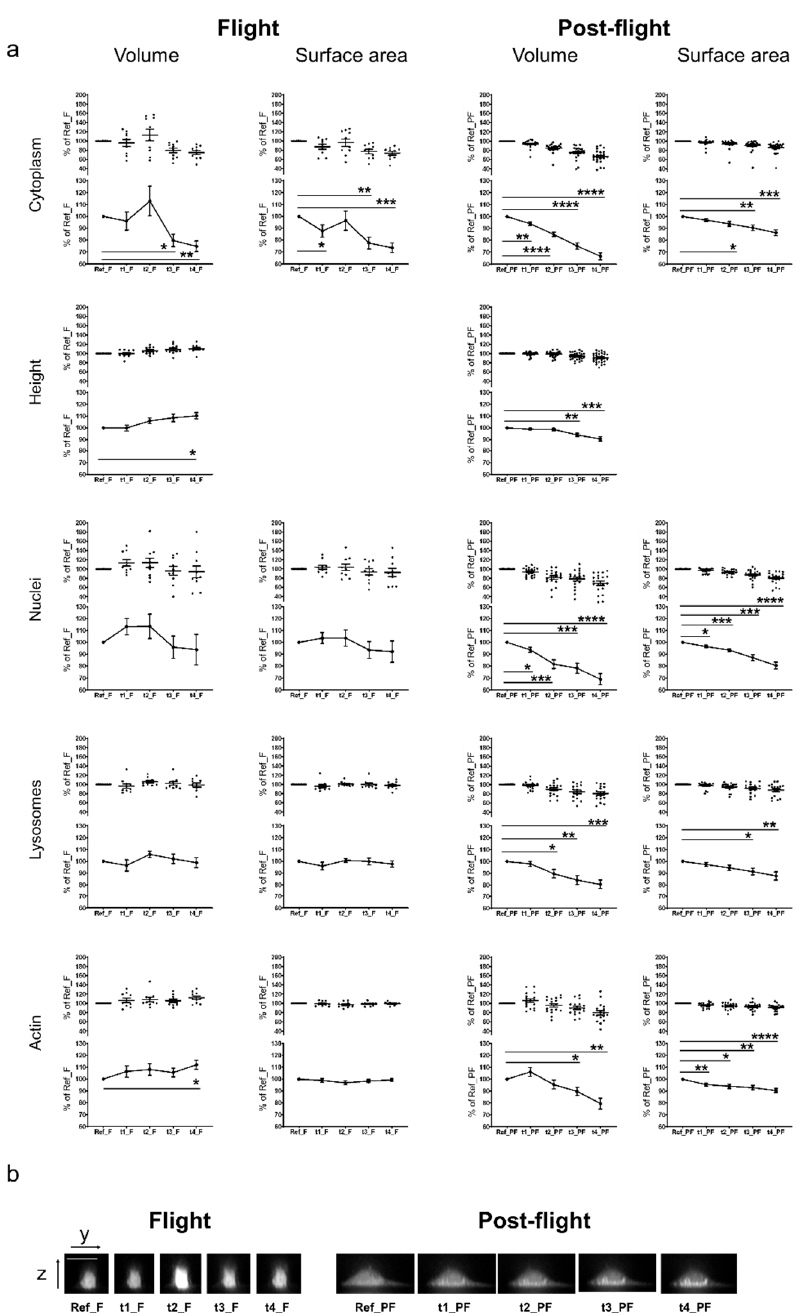
Figure 3. Microgravity-induced changes of cellular and sub-cellular structures. ( a ) Averaged values and statistical evaluation of the single cell analyses. Living human primary macrophages were stained with Nuclear Violet (nuclei staining), Calcein (cytoplasm staining), LysoBrite (lysosome staining), and SiR-actin (F-actin staining) and exposed to microgravity during the TEXUS-54 suborbital ballistic flight. 10 min before the flight and at four times during the flight, confocal microscopic pictures were taken with the confocal laser spinning disk fluorescence microscope FLUMIAS. Additionally, post-flight ground controls were performed. Volume, surface area, and the height of single cells (upper part of each graph) were quantified (software based) after correction of the laser-induced bleaching e ff ect. Averaged values are displayed in the lower parts of the graphs. Error bars represent SEM. p -values ≤ 0.05 were considered as significant ( p ≤ 0.05 = *, ≤ 0.01 = **, ≤ 0.001 = ***, ≤ 0.0001 = ****) ( b ) Sagittal z-stack images of representative example cells stained with the cytoplasmic marker Calcein for all time points of flight and post-flight acquisitions. Scale bar: 20 µm.